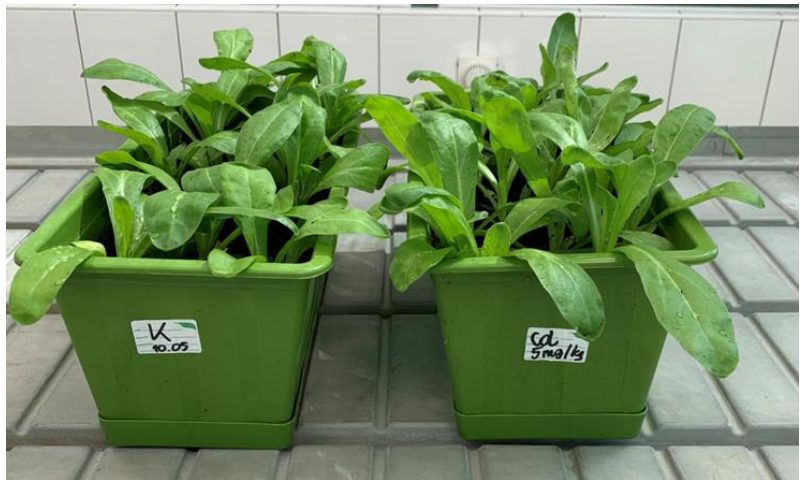
Figure 11. Three-week-old C. officinalis plants cultivated in the greenhouse.